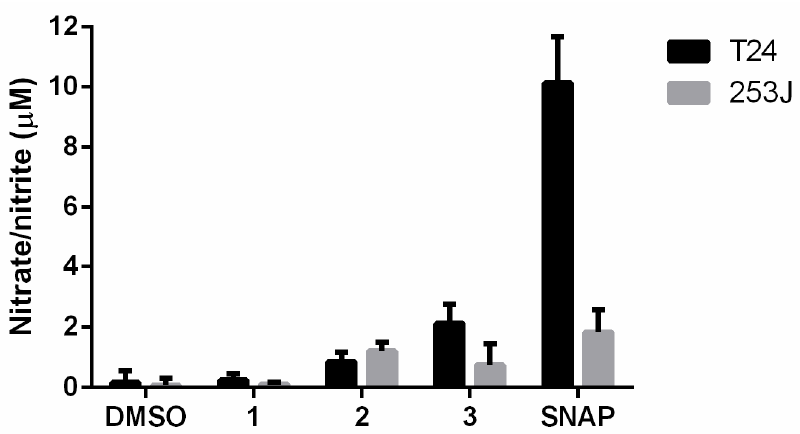
Figure 2. Levels of · NO produced by furoxans derivatives in T24 and 253J bladder cancer cell cultures. The results are the means ± standard deviation of three independent experiments. SNAP is the ·NO-releasing positive control compound.